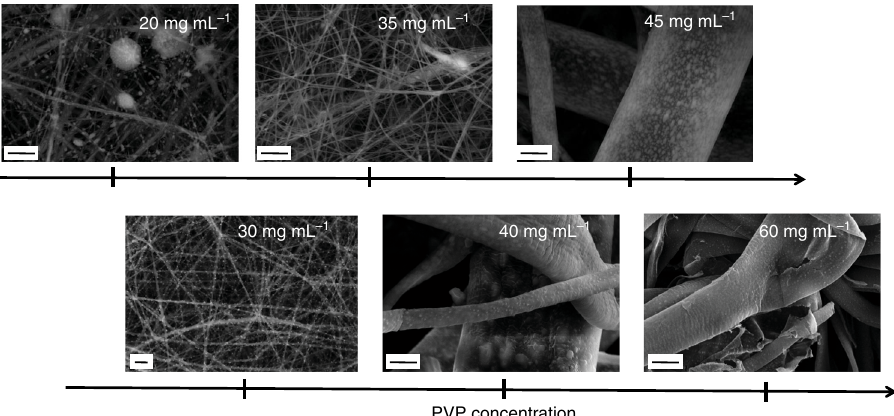
Fig. 2 Scanning electron microscope images of as-spun composite samples. The images show the nanoparticle-decorated caesium dihydrogen phosphate (CDP)-polyvinylpyrrolidone (PVP)-polyaniline (PANI) samples as a function of PVP concentration. Polymer beads are not present at PVP concentrations above 30 mg mL − 1 . The size and density of nanoparticles on the fi bres increase with increasing PVP concentration. The mean fi bre diameter is the smallest with a PVP concentration 30 mg mL − 1 . Scale bars represent 1 µ m